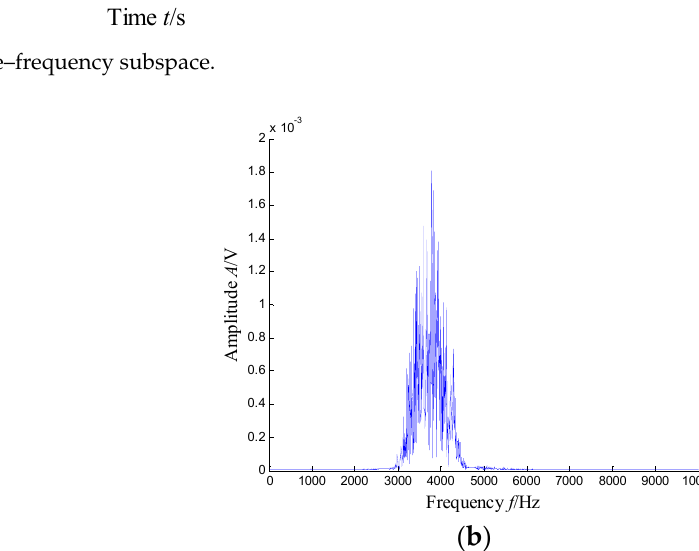
Figure 7. Waveform and spectrum of the extracted signal: ( a ) waveform and ( b ) spectrum.